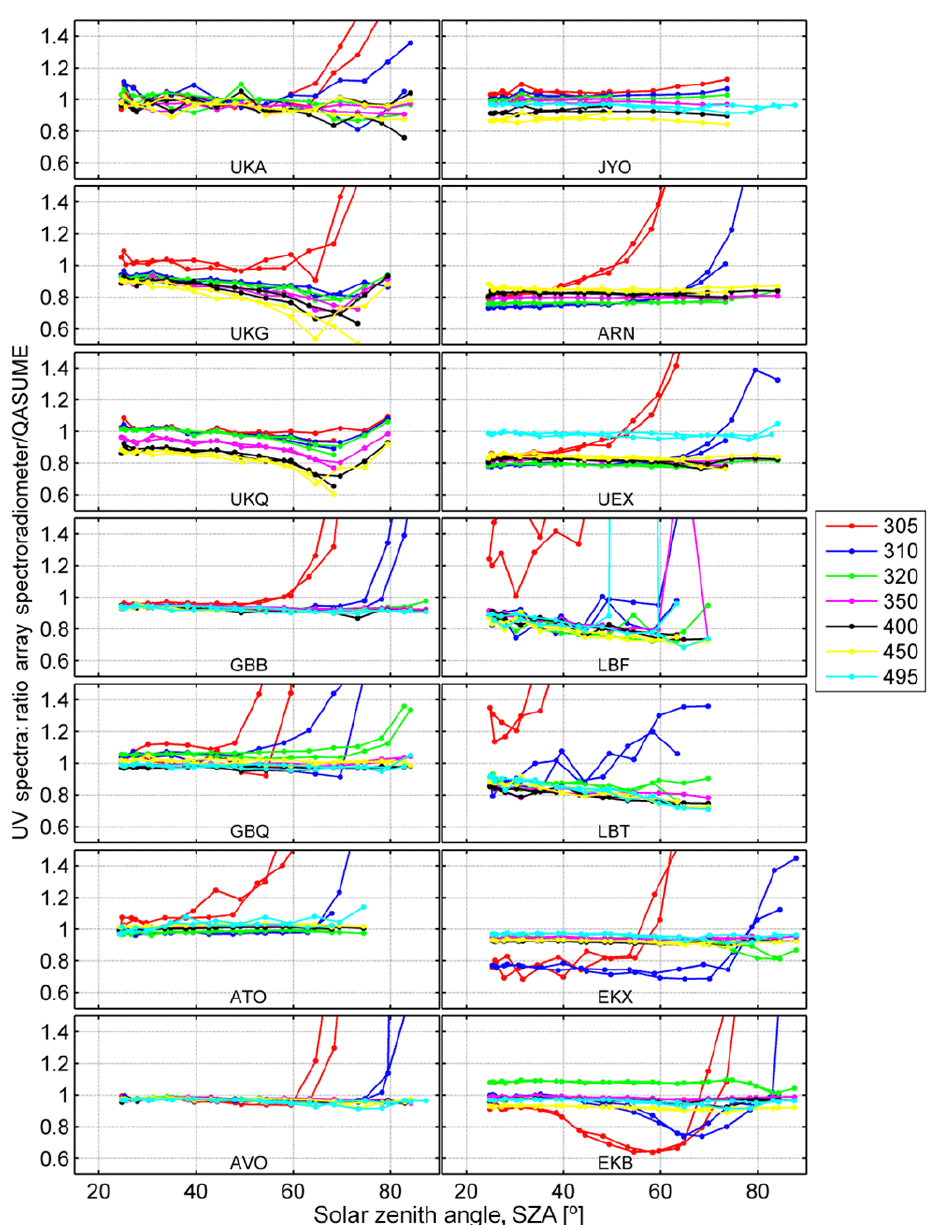
Figure 4. The ratios of spectral global UV irradiance derived from all array spectroradiometers to the QASUME reference spectroradiometer. The ratios are calculated from all available data of the campaign and are shown as a function of solar zenith angle and for selected wavelength between 305 and